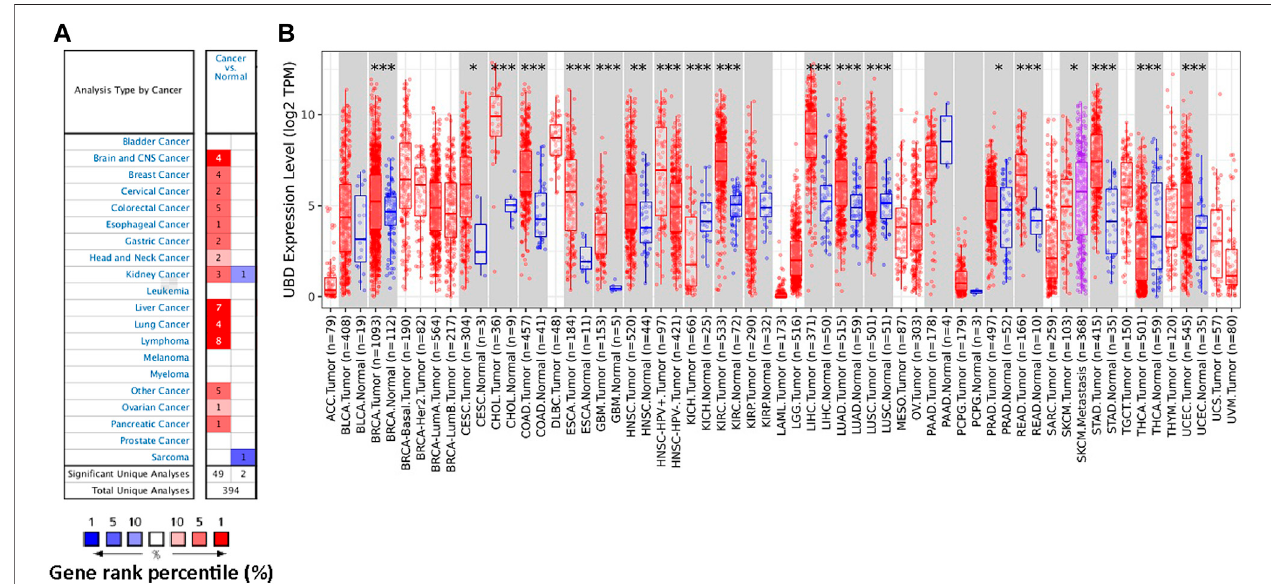
FIGURE1| Theexpression levelof FAT10 invariouscancertissuesortumor cells. (A) ThroughOncomine analysis,theexpression levelof FAT10 invarious normal or cancer tissues. (B) Through TIMER analysis, the expression level of FAT10 in various normal or cancer tissues (* p < 0.05, *** p <